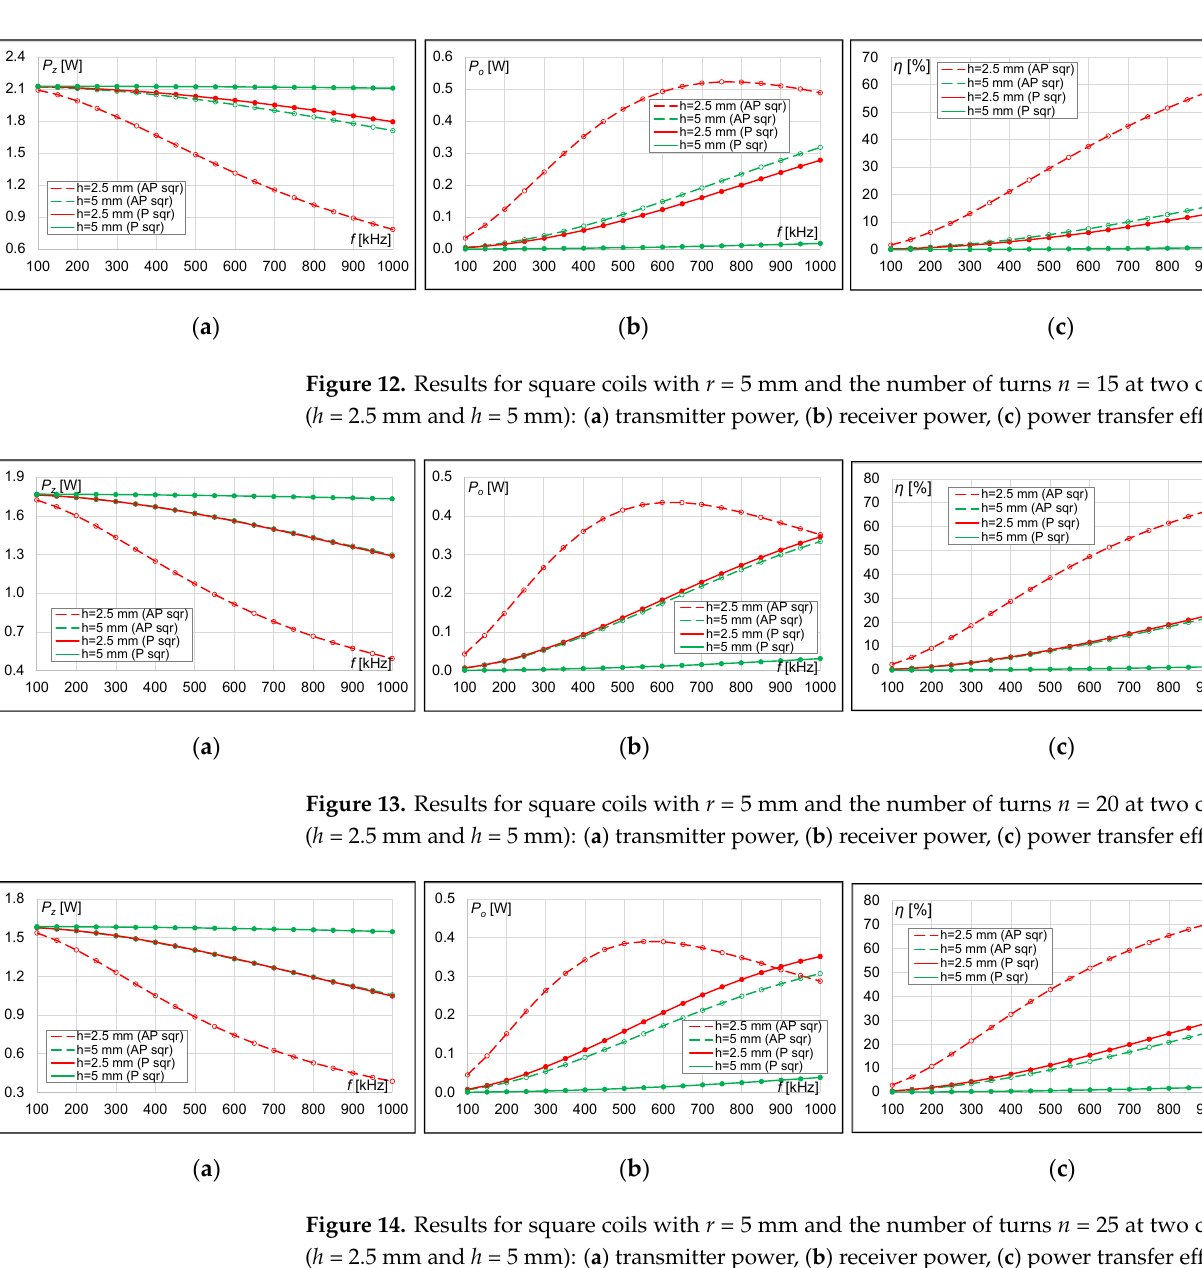
( c ) Figure 15. Results for square coils with r = 20 mm and the number of turns n = 40 at two distances ( h = 10 mm and h = 20 mm): ( a ) transmitter power, ( b ) receiver power, ( c ) power transfer efficiency. ( a ) ( b ) ( c ) Figure 16. Results for square coils with r = 20 mm and the number of turns n = 50 at two distances ( h = 10 mm and h = 20 mm): ( a ) transmitter power, ( b ) receiver power, ( c ) power transfer efficiency.